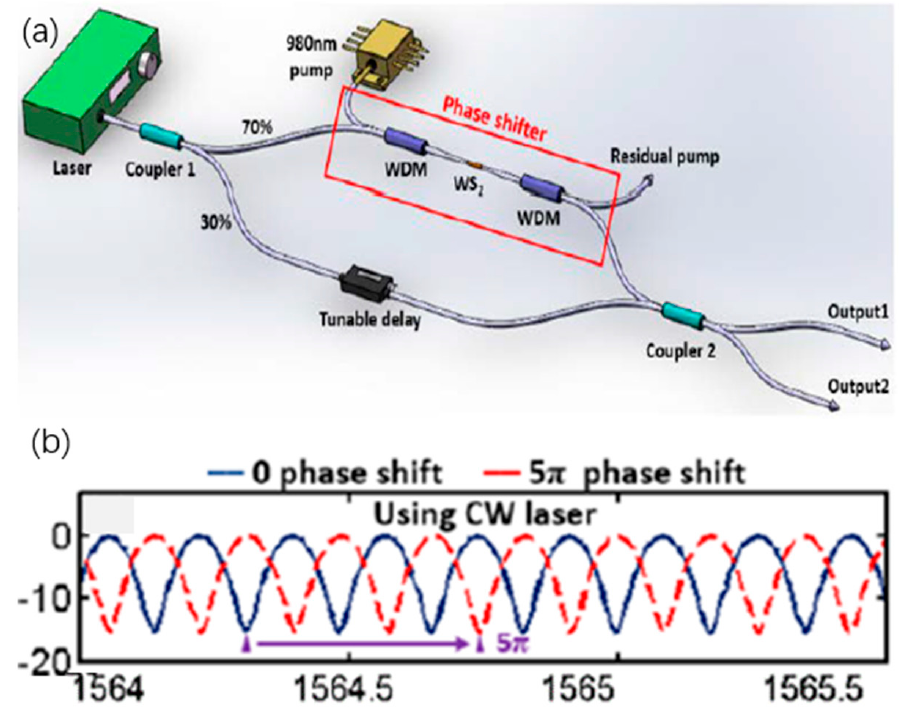
Figure 13. All-optical phase modulation based on WS 2 microfiber. ( a ) Schematic of the experimental setup of phase shifter based on WS 2 microfiber fiber, ( b ) Recorded typical spectrum with phase shifting at 5 π . Reprinted with permission from Ref. [139]. 2017, The Optical